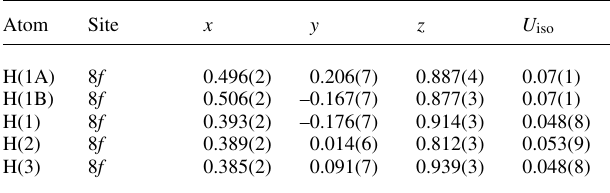
Table 2. Atomic coordinates and displacement parameters (in Å 2 )